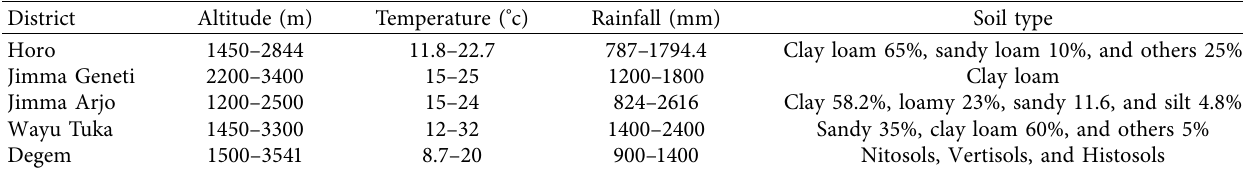
Table 1: Agro-ecologies of the